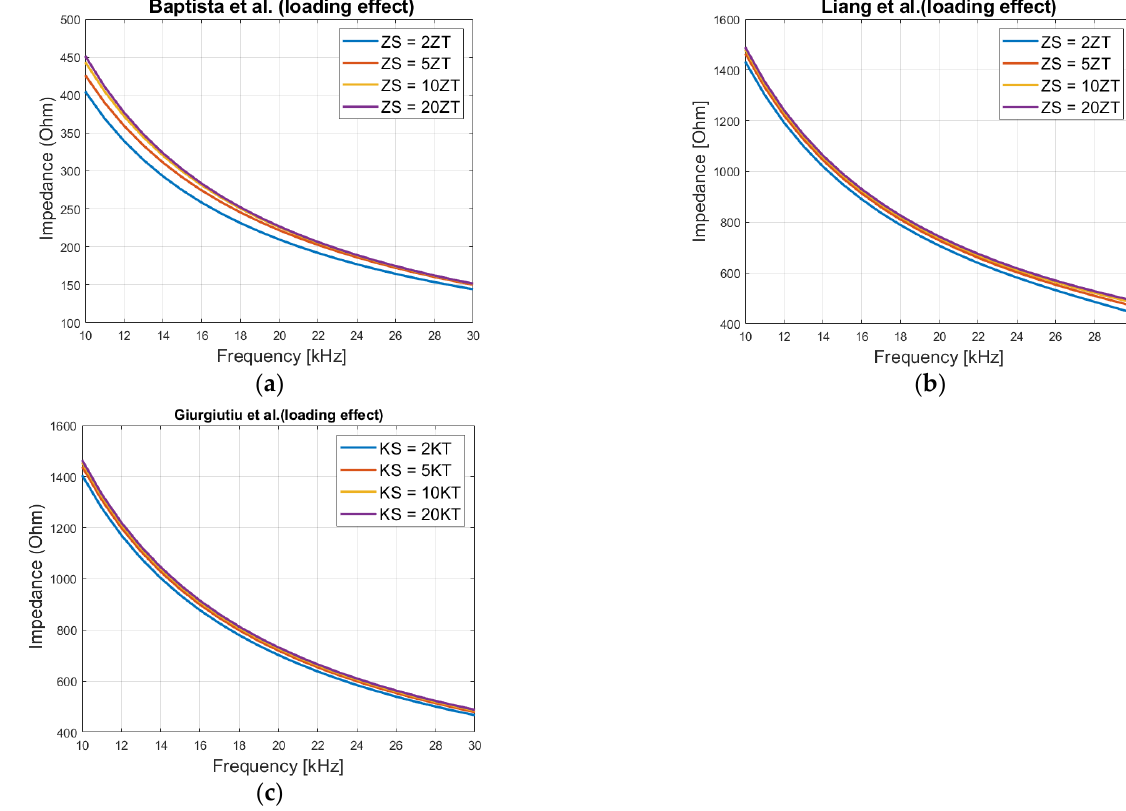
Figure 2. Loading effect on the electrical impedance, ( a ) Baptista et al. model, ( b ) Liang et al. model and ( c ) Giurgiutiu et al. model. Table 1. PZT patch parameters